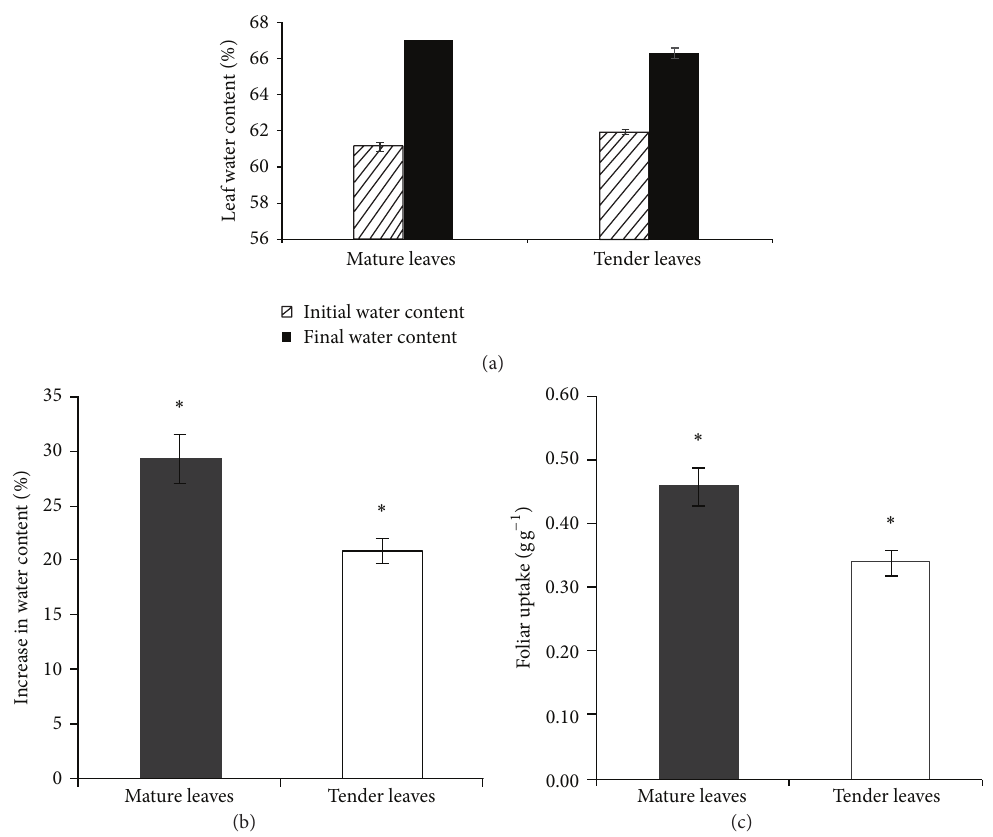
Figure 1: Water absorption by mature and tender leaves from detached twigs of T. ramosissima during submergence in deionized water for 6 h ( 𝑛 = 6 ). (a) The mean ( ± SE) leaf water content before and after submergence. (b) The mean ( ± SE) increase in leaf water content. (c) The mean ( ± SE) foliar uptake quantity standardized by leaf dry weight. The asterisk indicates increase in leaf water content or foliar uptake of the two leaf types reached significant level.